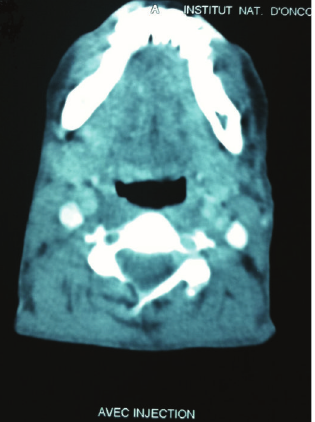
Figure 4: The assessment computed tomography scan of cervical after 4 cycles of chemotherapy showed a complete